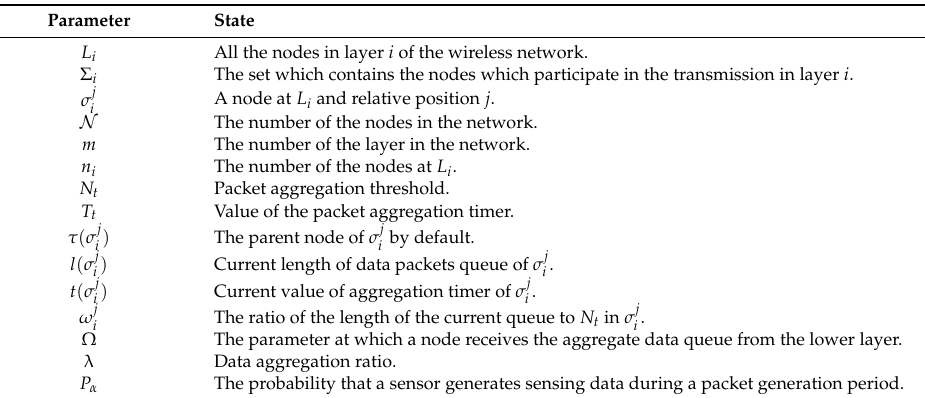
Table 1. Parameter description.